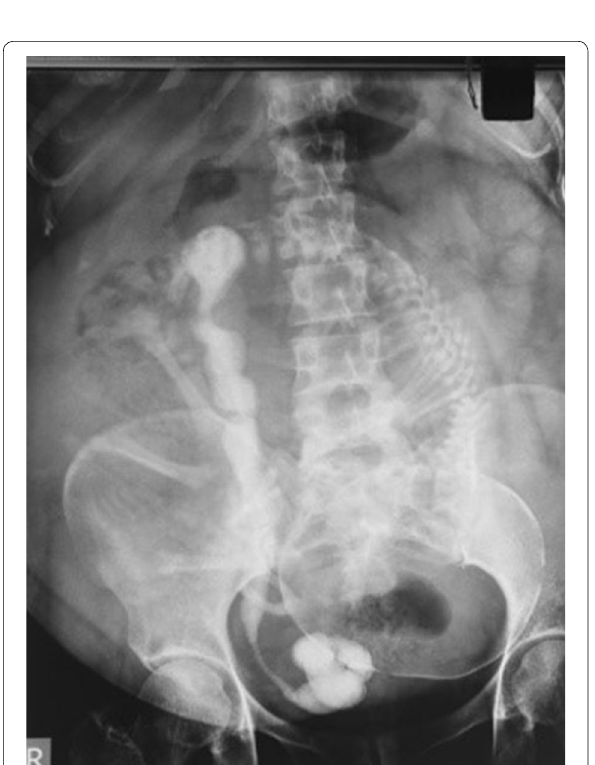
Fig. 1 X-ray KUB scan showing the forgotten stent